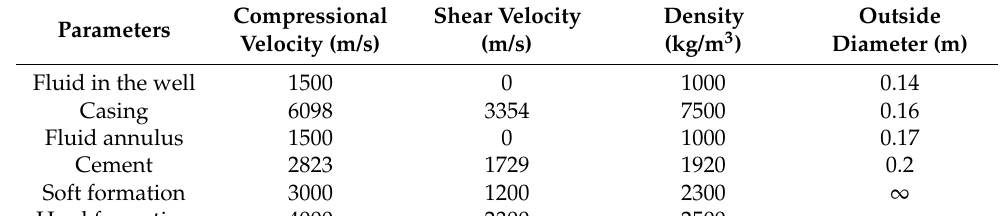
Table 1. Parameters of the cased ‐ hole acoustic model.